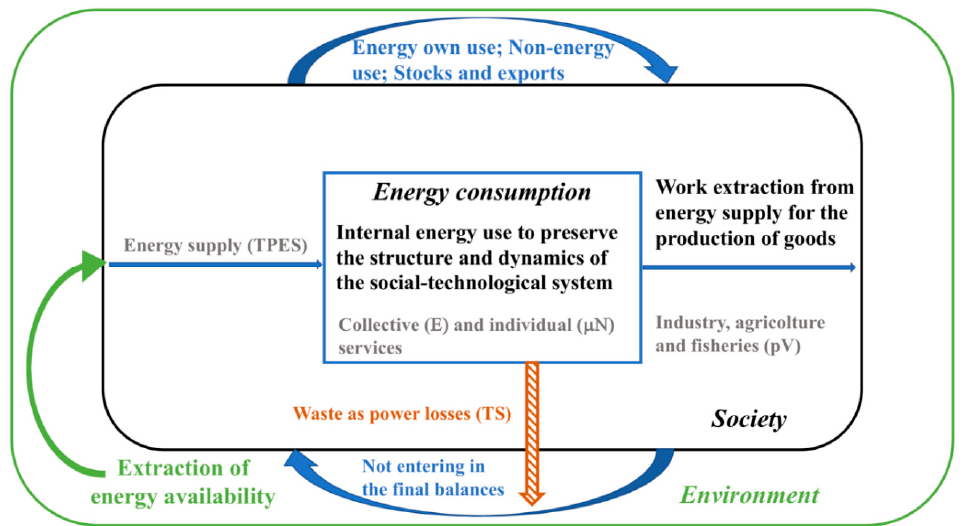
Figure 1. Basic simplified representation of societal energy metabolism and its components. Energy availability, embedded in energy sources, is extracted from the environment, becoming available to humans as energy supply (TPES). Energy is processed within society, considering also the use of technologies, to maintain its structure and functions, while some of it is used to support the production of different goods. Finally, part of the energy is dissipated in the environment, while a part of TPES re ‐ circulates within the system without being consumed along metabolic processes.